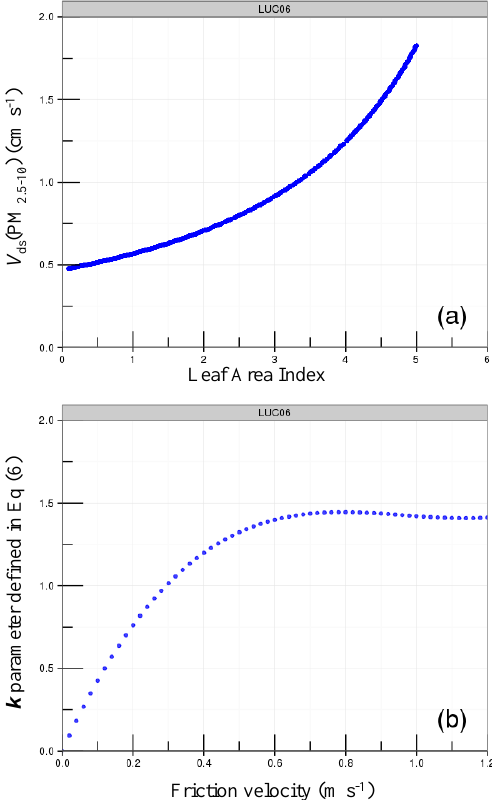
Fig. 4. (a) Bulk V ds (PM 2 . 5 − 10 ) vs. LAI under a fixed u ∗ (1.0ms − 1 ) for LUC 6, and (b) k (defined in Eq. 6) vs. u ∗ for LUC 6.